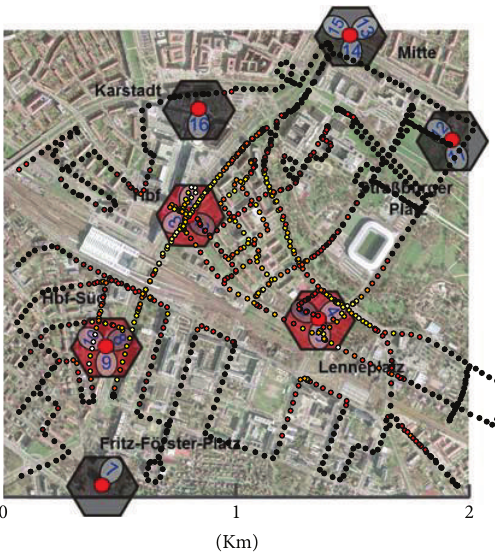
Figure 15: SNR in cooperation area using the tortoise concepts.